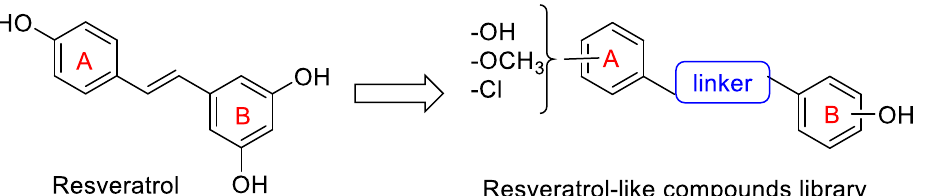
Figure 1. Chemical structure of resveratrol and general structure of the library of resveratrol-like compounds.